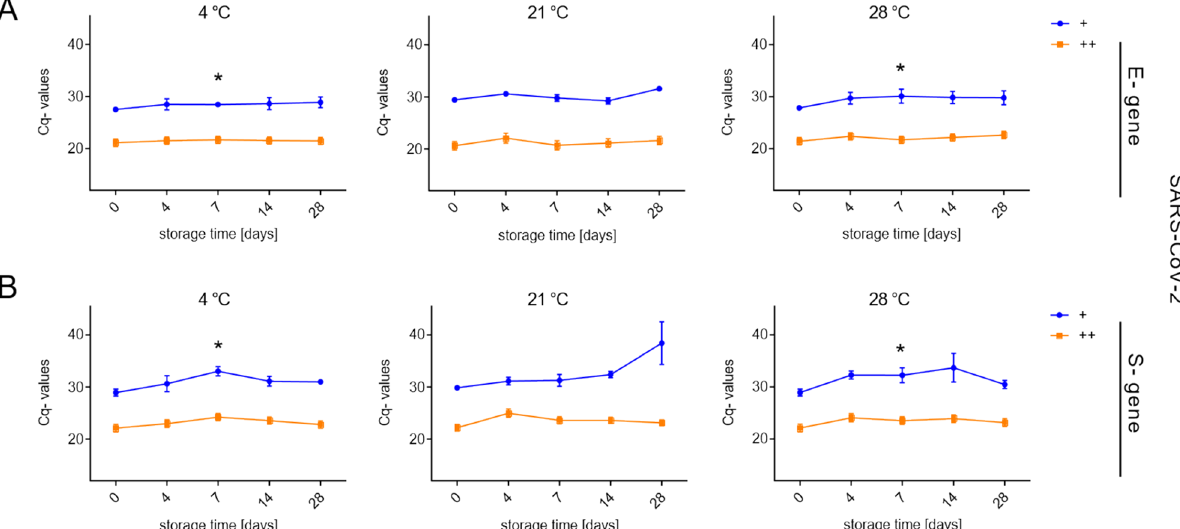
Figure 3. Long-term storage, even at high temperatures, allows adequate detection of weakly positive SARS- CoV-2 specimens. RT-PCR measurements of clinical specimens strongly (orange rectangle) and weakly positive (blue point) for SARS-CoV-2 stored in NaCl or HBSS VTM over 4 weeks at 3 different temperatures (4 °C, 21 °C and 28 °C). Cq-values ± SEM for SARS-CoV-2 + at 4 °C n = 4; at 21 °C n = 10 and 28 °C n = 2 and for SARS- CoV-2++ at 4 °C n = 20; at 21 °C n = 17 and 28 °C n = 22 are shown. * p -values < 0.05, repeated measurement ANOVA and Wilcoxon signed rank test. The stability of SARS-CoV-2 + samples kept at 4 °C and 28 °C varied significantly from SARS-CoV-2++ after 7 days (* 4 °C p E = 0.0008, p S = < 0.0001; 28 °C p E = 0.0049, p S = 0.0001); however, no significant changes in the Cq-values could be observed for the specimens stored at 21 °C ( p E = 0.73, p S =